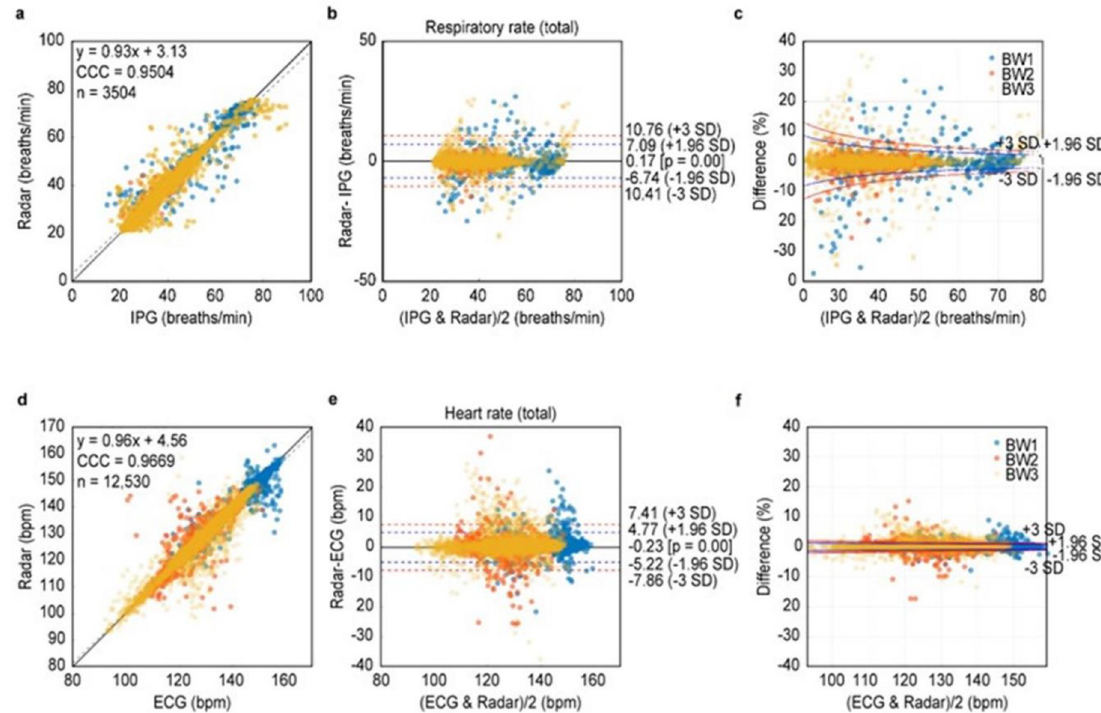
Fig 5. Agreement for the RR and HR between IR-UWB radar and conventional ECG/IPG. The RR Rd was highly correlated with the RR IPG (A). BA plot showing that the mean bias between the RR Rd and RR IPG was only 0.17 breaths/minute, which is negligible in clinical practice (B). The width of the 95% LOA of the percent difference between the RR Rd and RR IPG was less than 16.8% of the average RRs at the maximum width and gradually decreased with increasing average RRs (C). The HR Rd was also highly correlated with the HR ECG (D). BA plot showing that the mean bias between the HR Rd and HR ECG was only -0.23 beats/minute, and the width of the 95% LOA was approximately 7.5% of the median average HR (E). The width of the 95% LOA of the percent difference between the HR Rd and HR ECG was less than 2.8% of the average HR at the maximum width and gradually decreased with increasing average HRs (F). BW1, body weight � 2 kg; BW2, 2 < body weight � 3 kg; BW3, body weight > 3